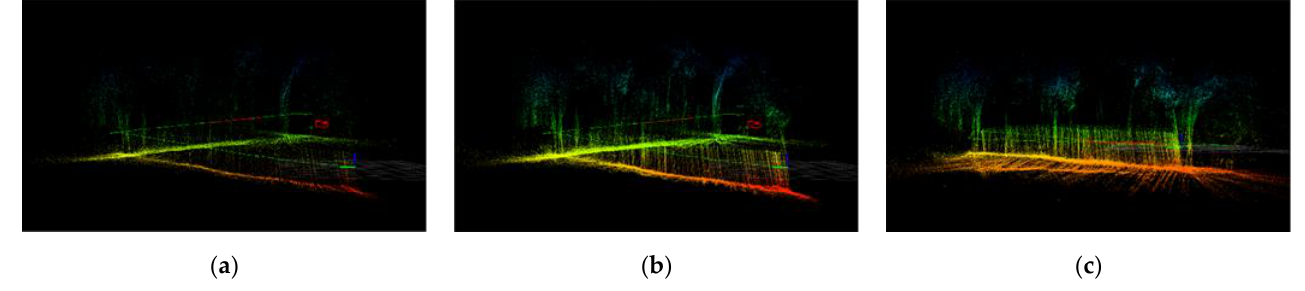
Figure 5. The 3D point cloud densification and loop closure correction: ( a ) sparse point cloud; ( b ) dense point cloud; ( c ) dense point cloud loop closure correction.